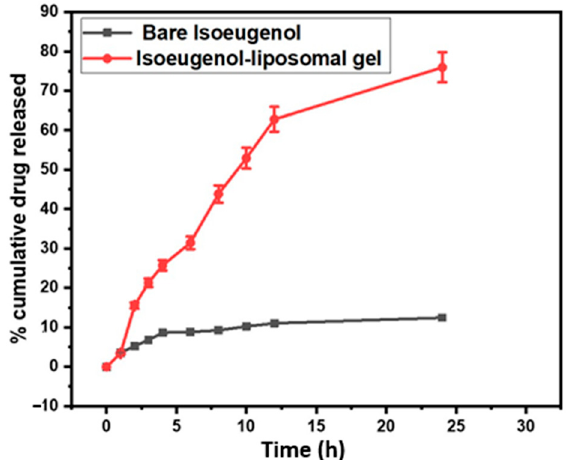
Figure 7. Comparative in vitro drug released; a study of bare isoeugenol and isoeugenol-liposomal gel in pH 6.0 media for 24 h. Study is performed in triplicates and all data are expressed as the mean ± standard deviation. Table 1. r 2 value of bare isoeugenol and isoeugenol-liposomal gel using di ff erent kinetic studies for 24 h. Date presented is taken from in vitro drug release study.